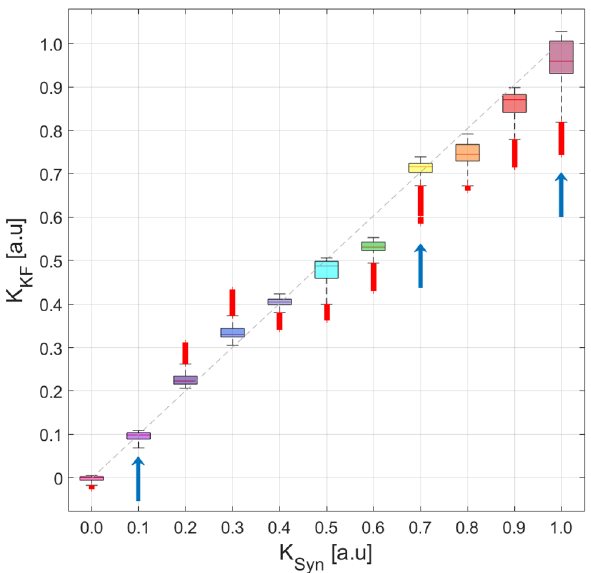
Figure 4. UKF estimation of the parameter K versus the real value. The comparison is made using boxplots. For each boxplot, the red line is the median, the upper and lower whiskers of the bars represent the maximum and minimum limits, and the red points refer to outliers. For the construction of each boxplot, we use 90.000 data points obtained from independent runs of the UKF algorithm for each synthetic data set. The dashed-black diagonal line indicates the value where the real K and the estimated K are the same. Blue arrows correspond to the results shown in Fig. 2.